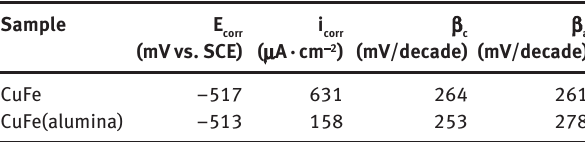
Table 4: Corrosion characteristics of sintered samples extracted from cyclic potentiodynamic polarization curves.